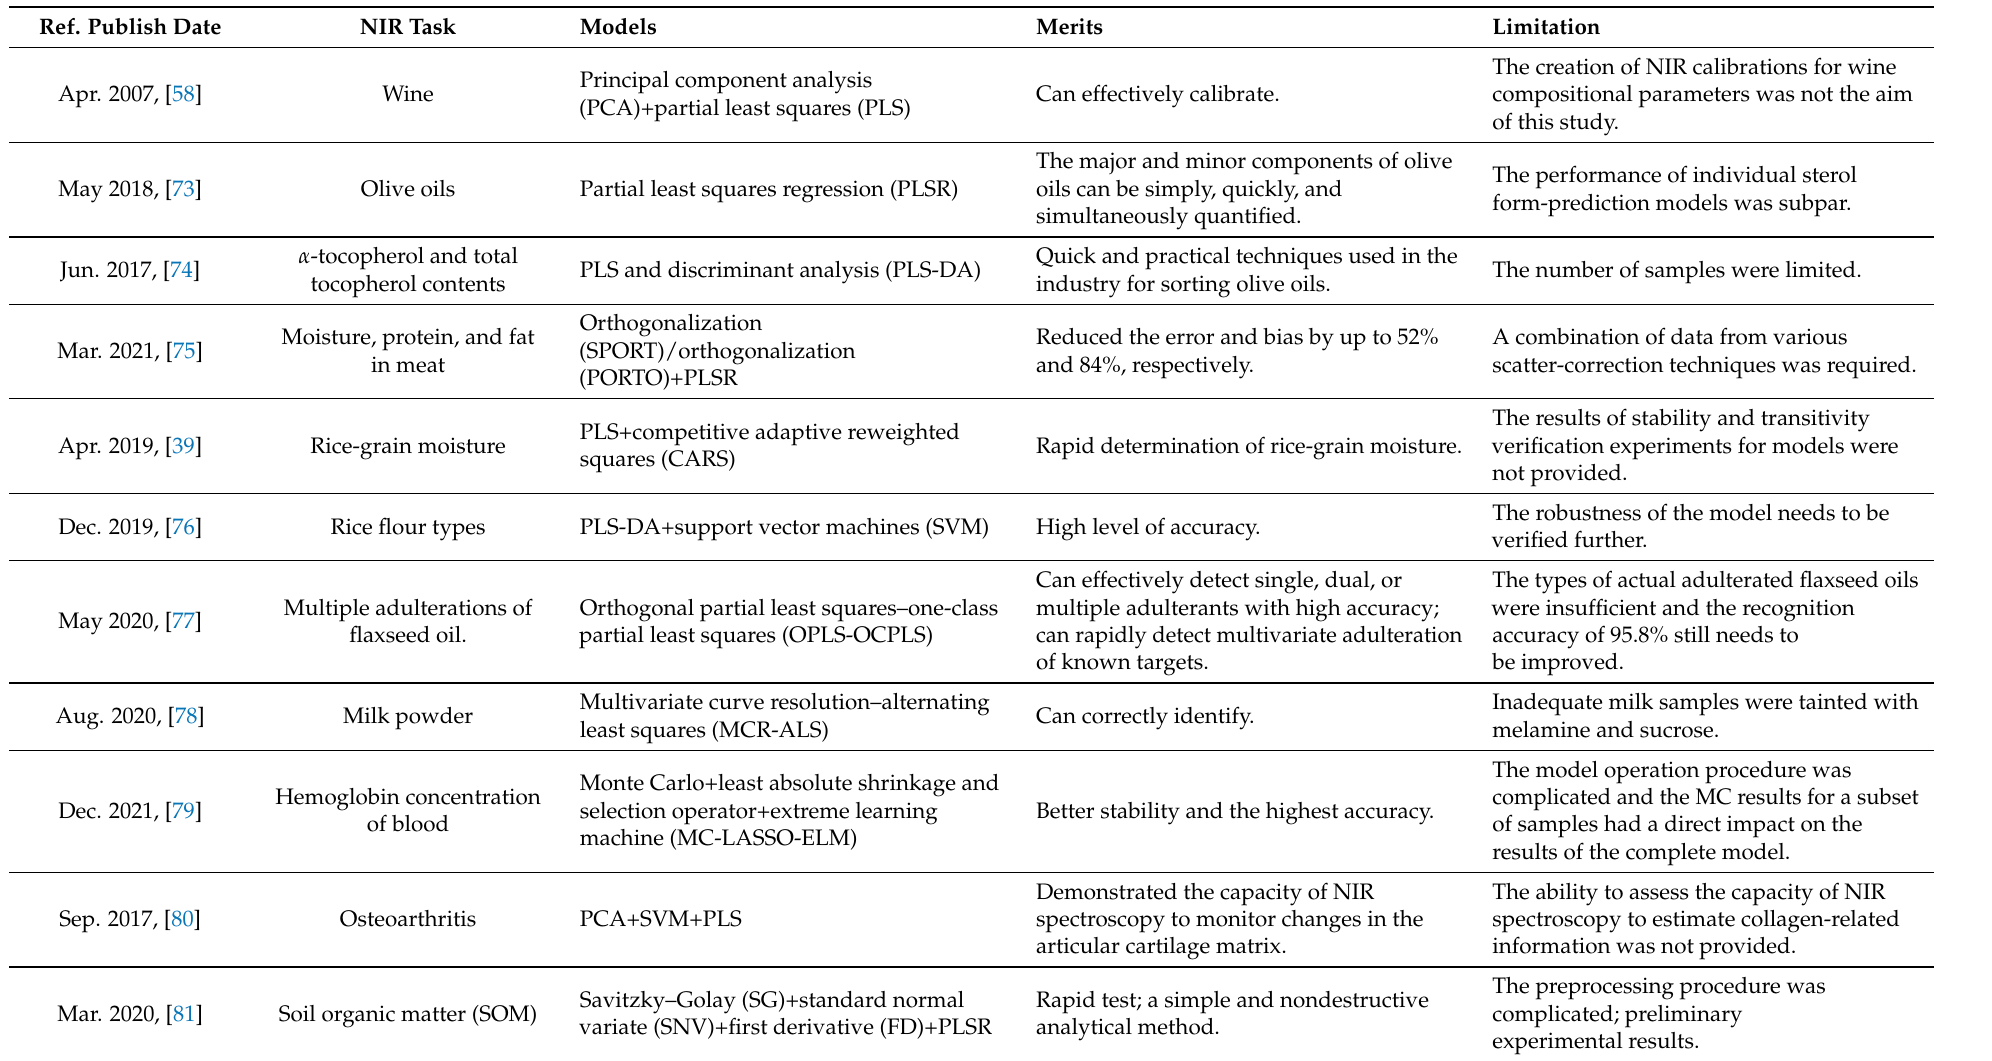
Table 2. Summary of traditional machine learning methods used in